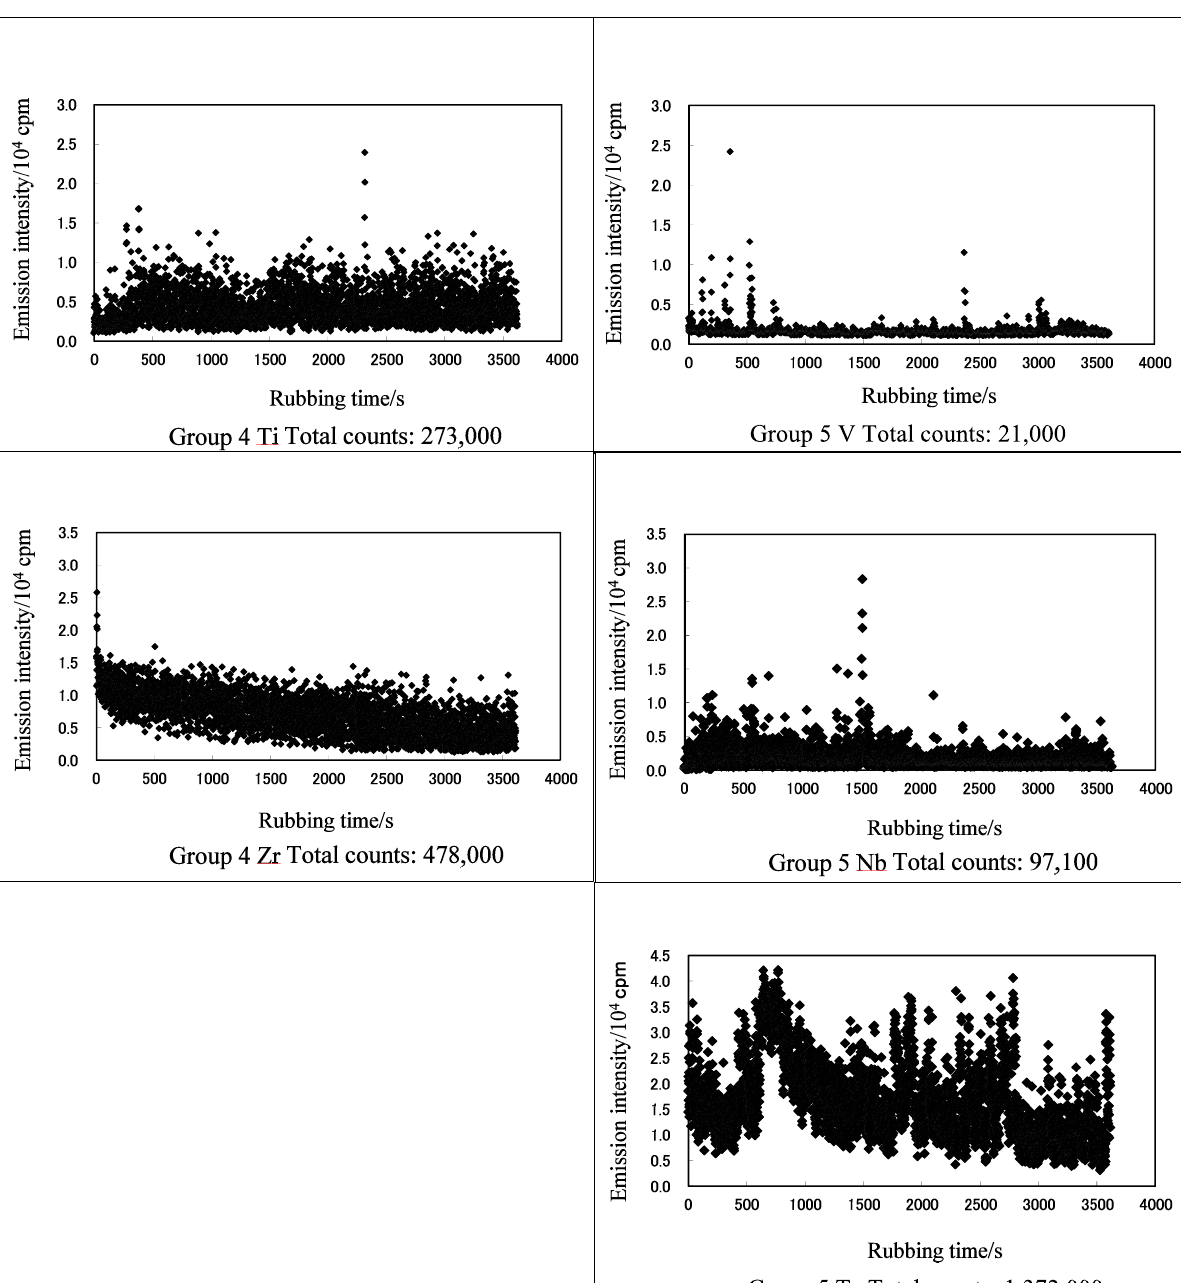
Figure 1. The change in intensity (cpm: counts/min) of TriboEE with rubbing time for groups 4 (Ti and Zr) and 5 (V, Nb, and Ta), giving the median value of TriboEE intensity.